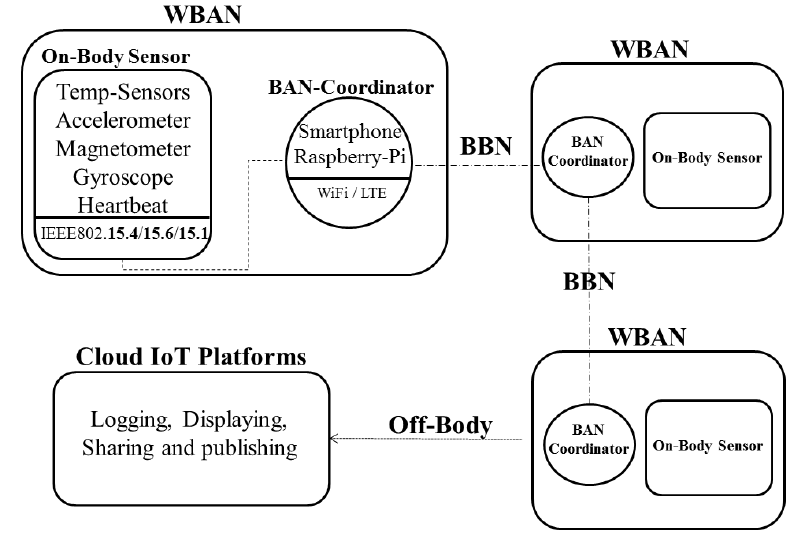
Figure 1. General architecture of the wireless body-area-network system. BAN: Body-Area-Network, BBN: Body-to-Body communication, Off-Body communication: all non-BAN and non-BBN communications.